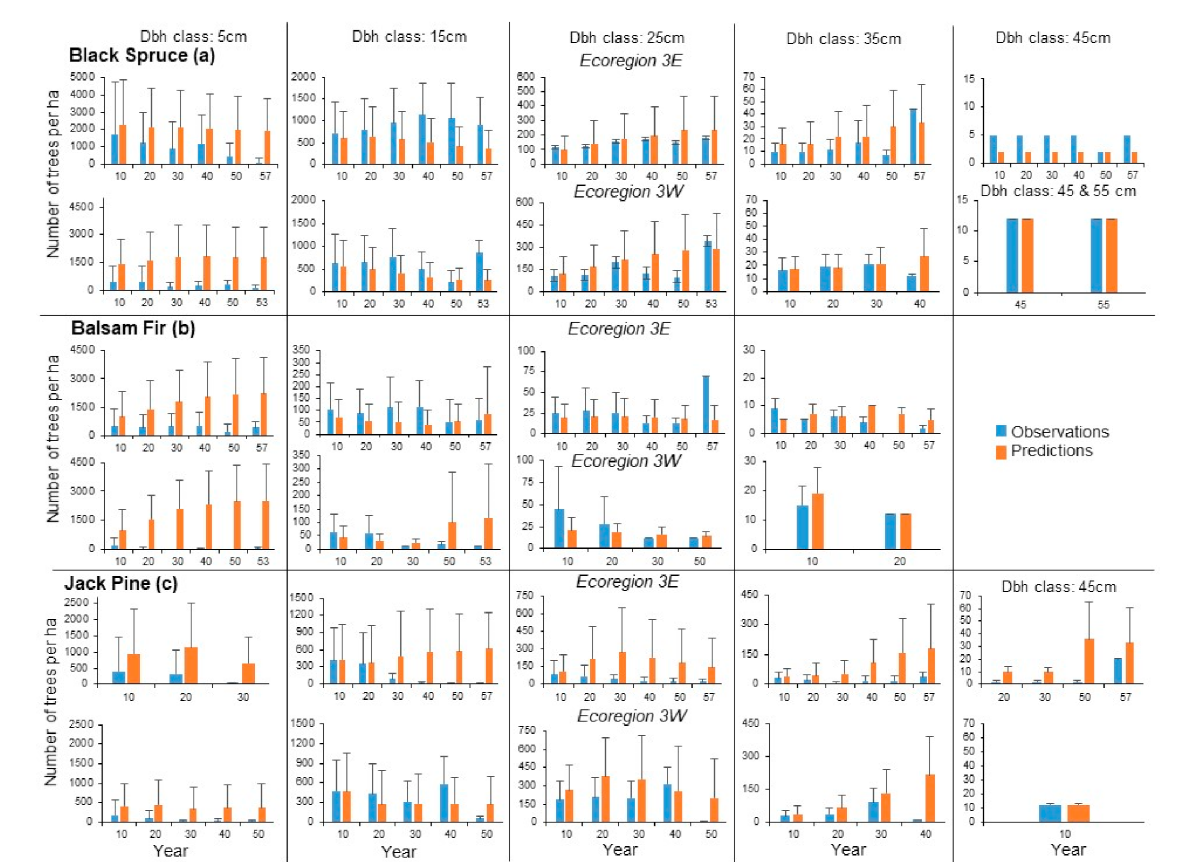
Figure 6. Comparisons between mean observed and predicted stand densities for black spruce ( a ), balsam fir ( b ) and Jack pine ( c ) over years in ecoregions 3E and 3W of the boreal forest region of northern Ontario, Canada. Error bars are standard